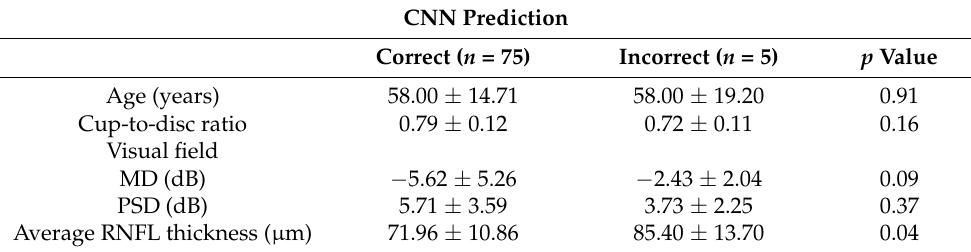
Table 4. Clinical characteristics and prediction accuracy of the TVGH model in images with primary open angle glaucoma. CNN Prediction Correct ( n = 75) Incorrect ( n = 5) p